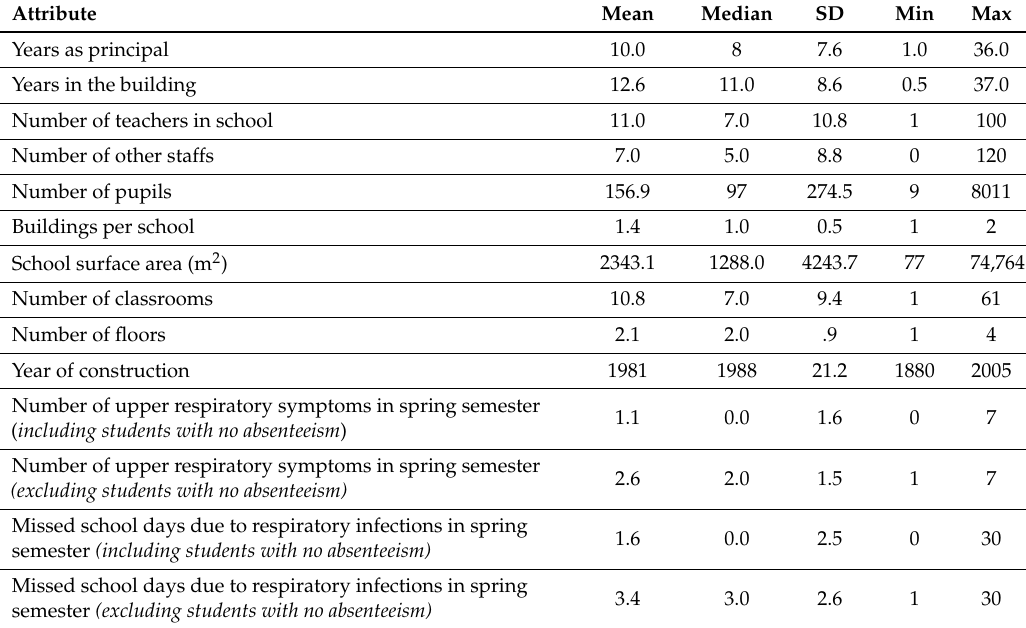
Table 1. Background information of sampled schools and selected health outcomes of students (including all students responding to the questionnaire, N = 4248).